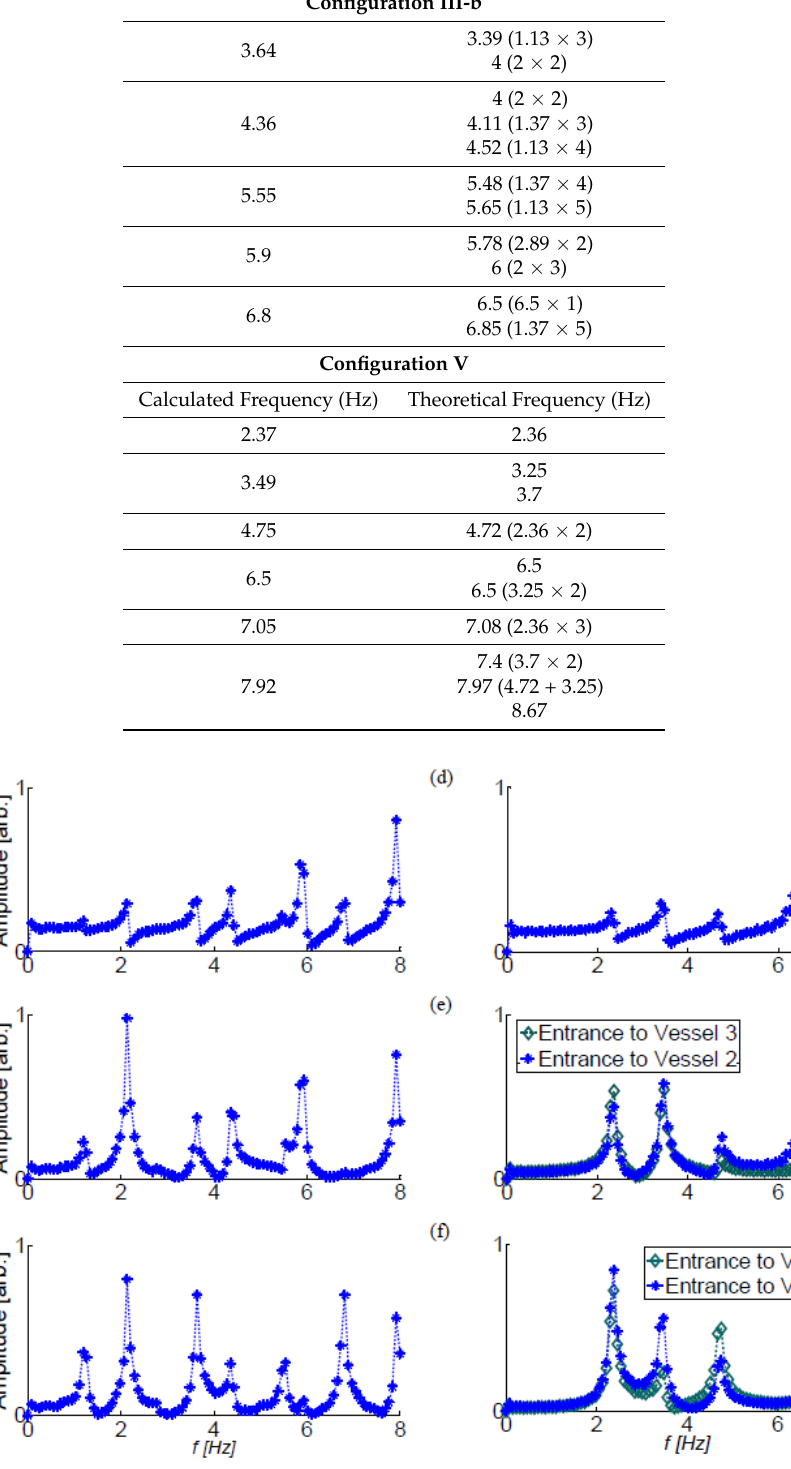
Figure 4. The FFT of the monitored pressure at the entrance to the various vessels of configurations III-b and V. ( a – c ) represent the first, the second and the third vessels in configuration III-b, respectively, ( d ) shows the first vessel in configuration V, and ( e , f ) the other four vessels in configuration V.